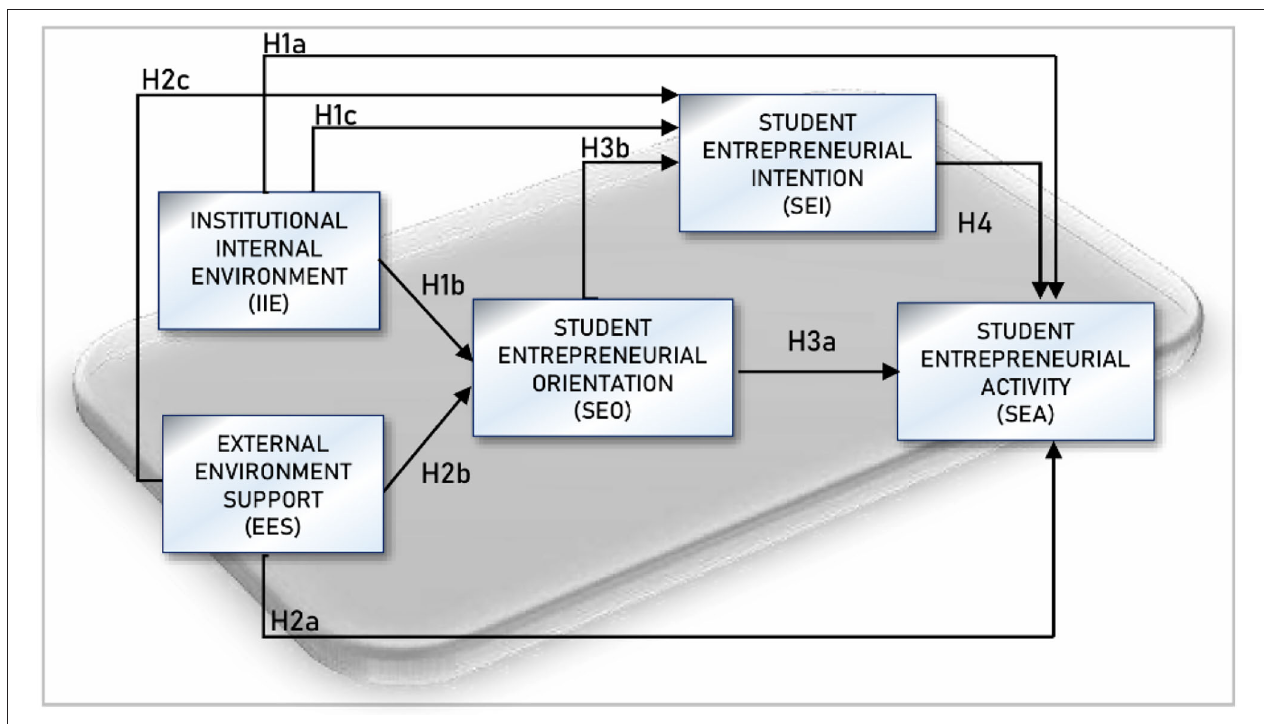
FIGURE 1 | Conceptual